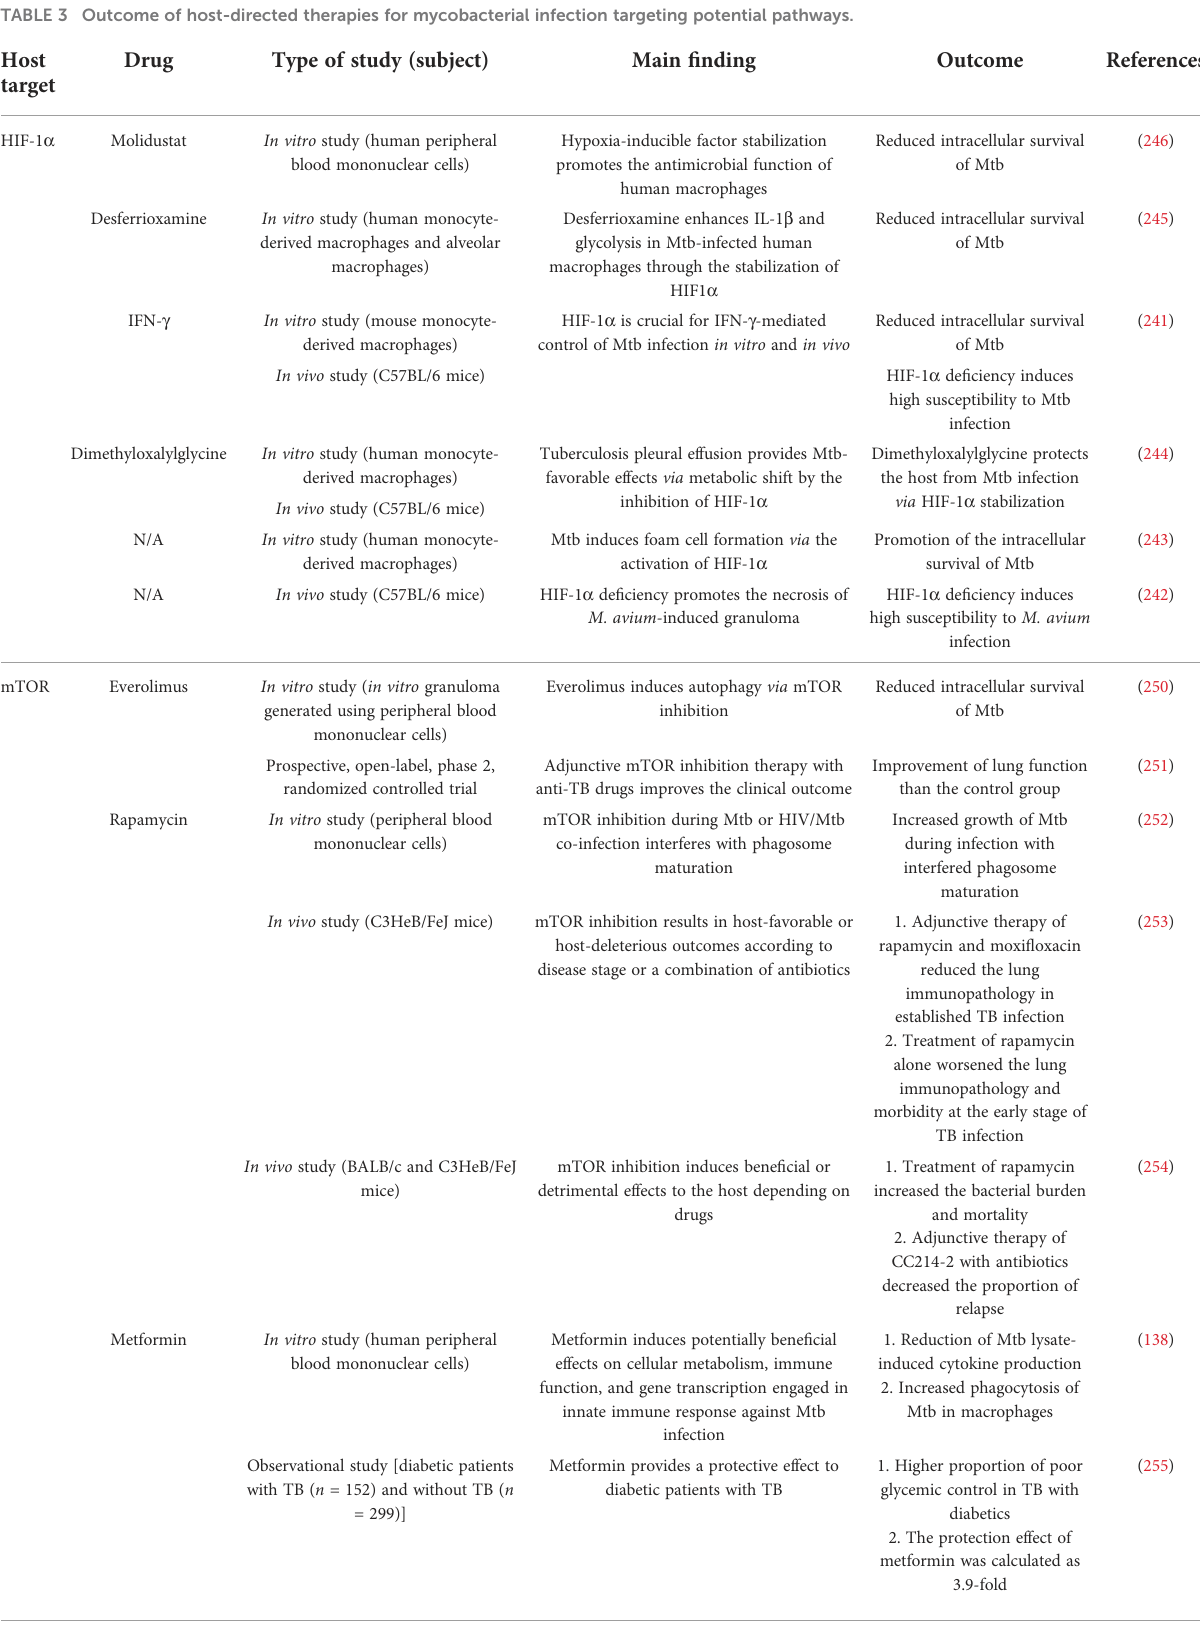
TABLE 3 Outcome of host-directed therapies for mycobacterial infection targeting potential